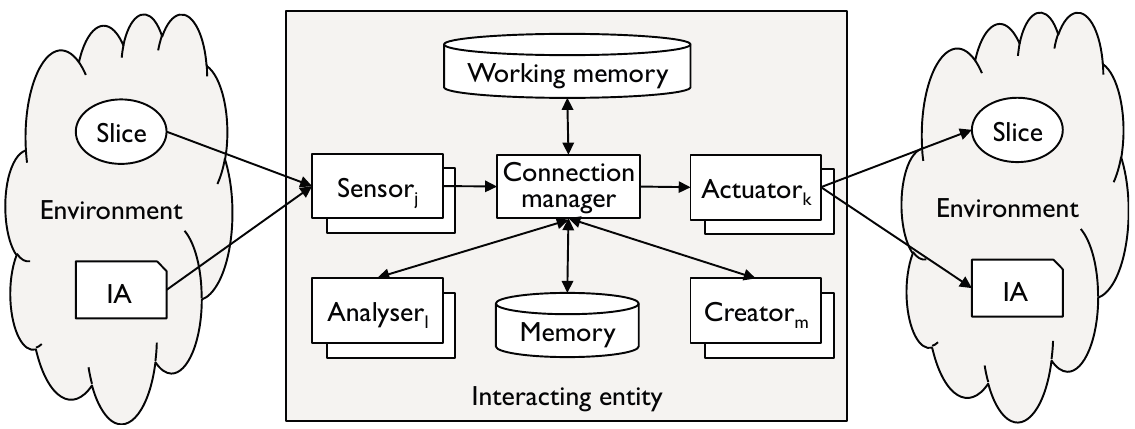
Figure 2. The generic IE and modelling